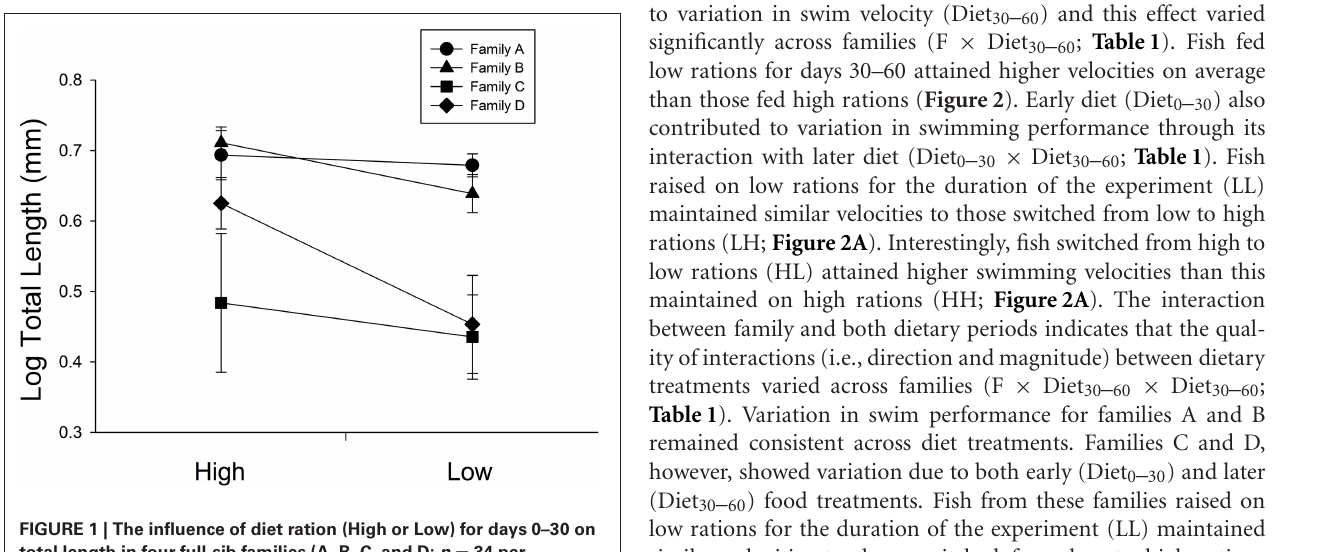
FIGURE 1 | The influence of diet ration (High or Low) for days 0–30 on total length in four full-sib families (A, B, C, and D; n = 34 per treatment). Error bars represent standard errors. Diet and family were significant sources of variation ( P = 0 . 0026, < 0.001, respectively).